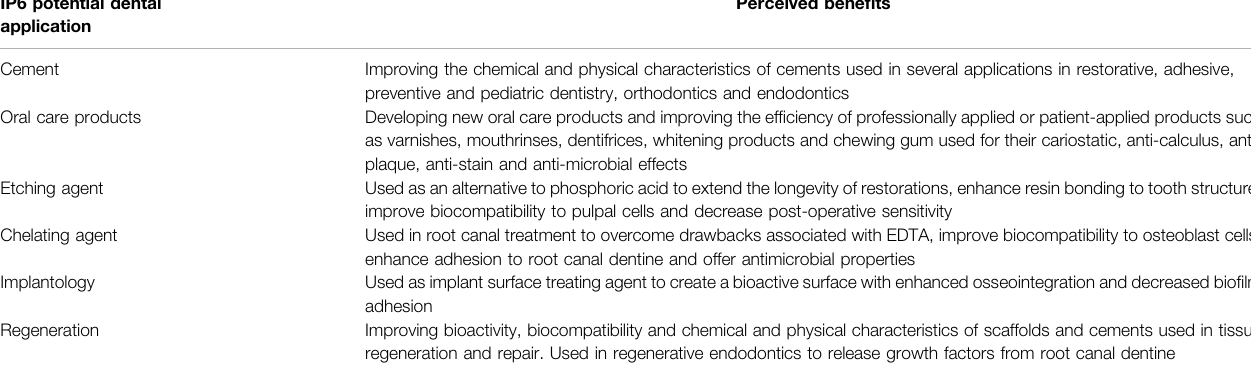
TABLE 1 | Summary of the potential applications of IP6 and the perceived bene fi ts in dentistry. IP6 potential dental application